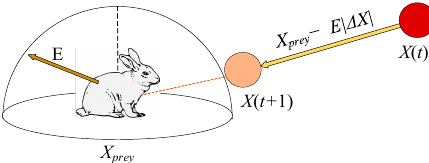
Figure 6. Example of overall vectors in hard besiege